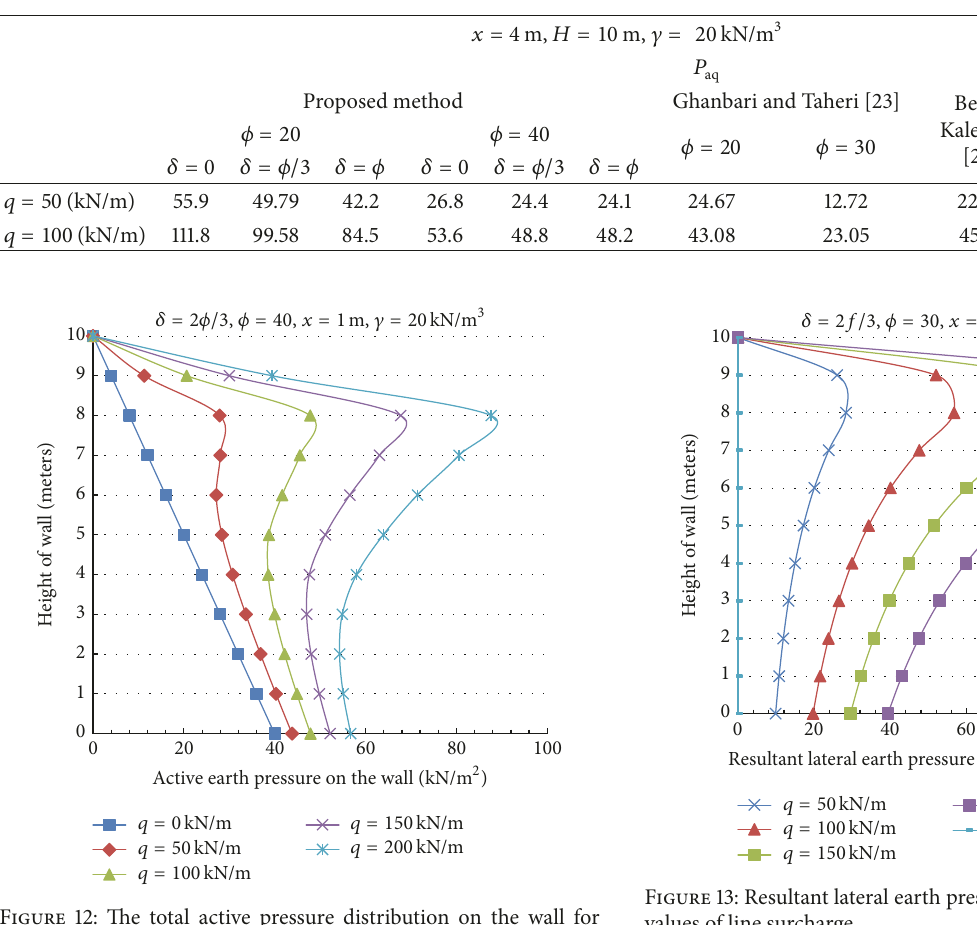
Table 3: Comparison of the results of the proposed method with Ghanbari and Taheri [23] and specifications (1994).